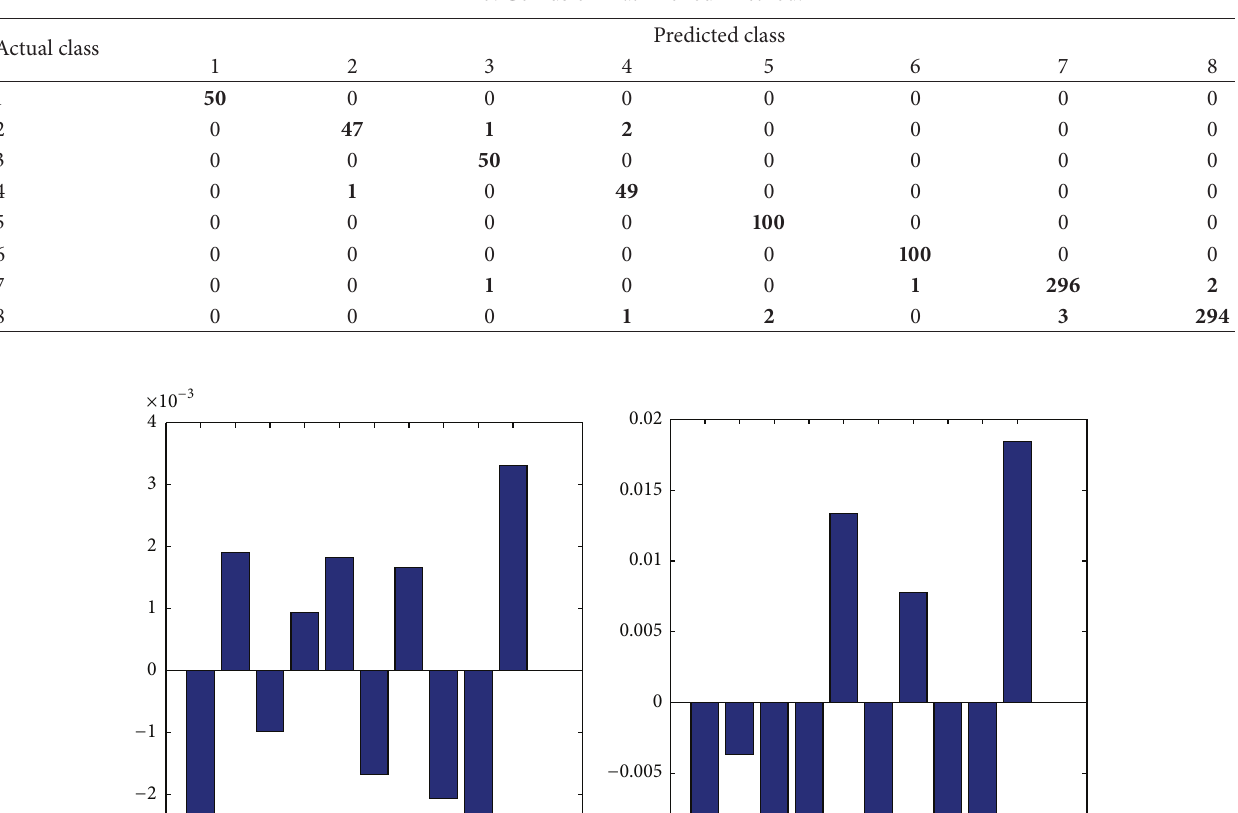
Table 5: Confusion matrix of our method.